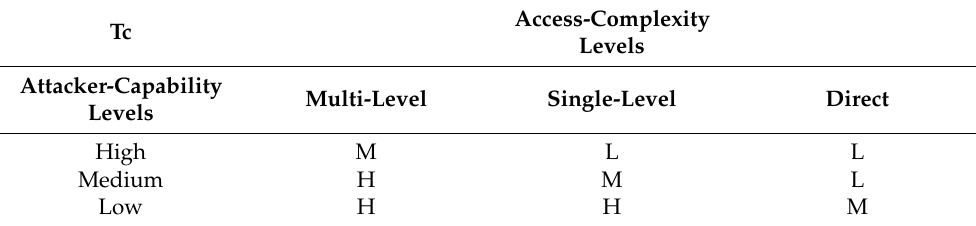
Table 3. Threat complexity matrix.